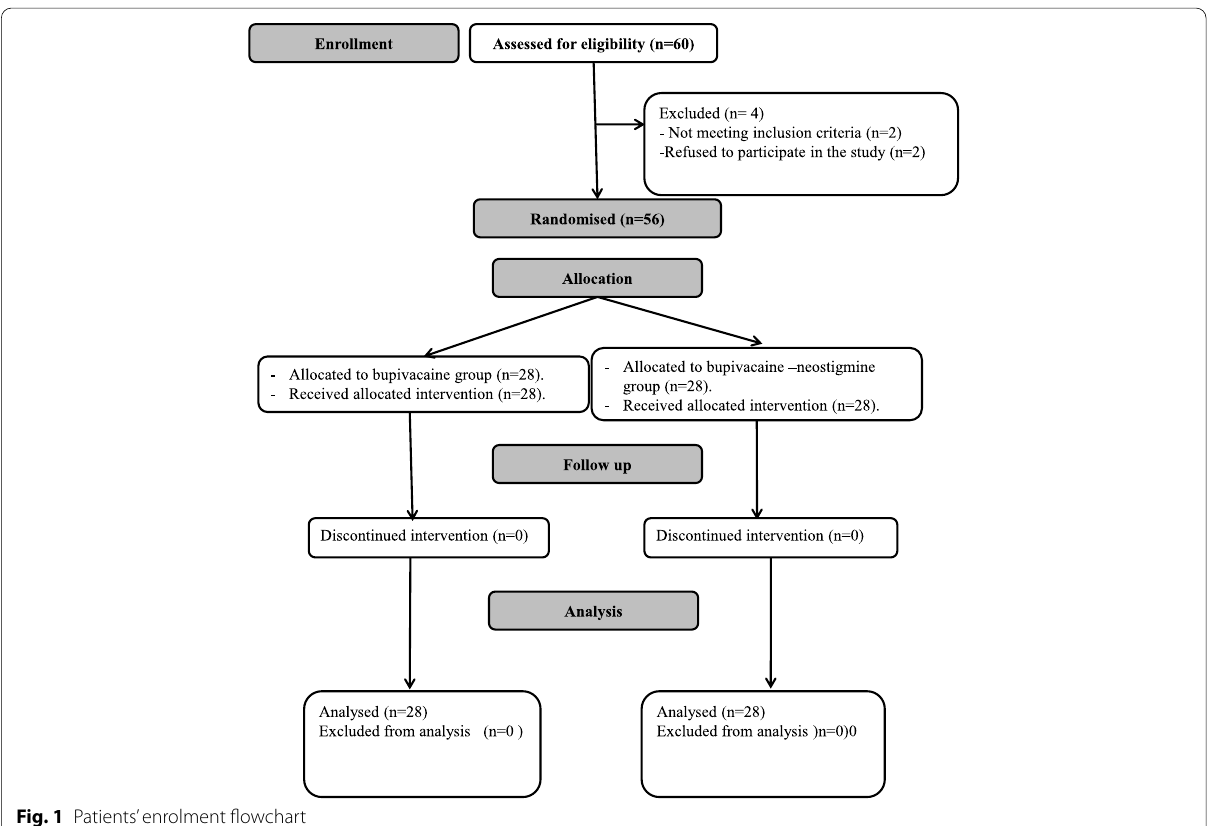
Fig. 1 Patients’ enrolment flowchart